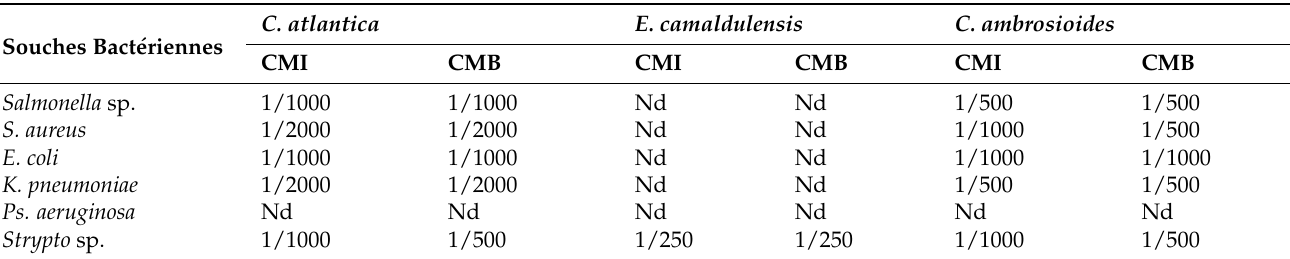
Table 4. MIC and MBC of essential